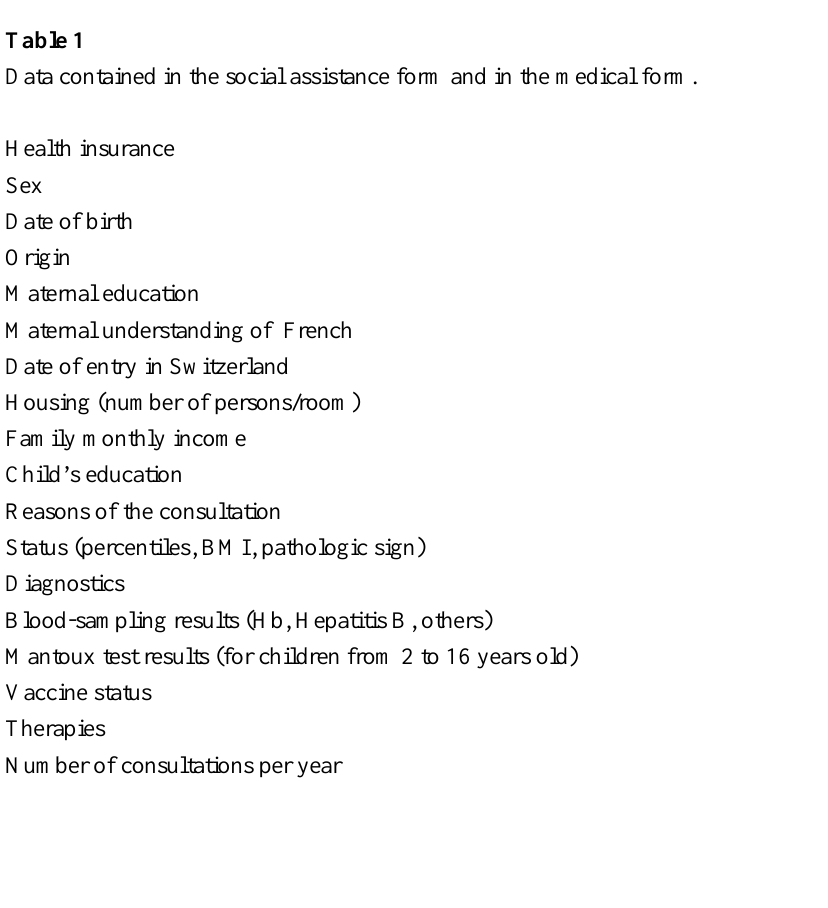
Data contained in the social assistance form and in the medical